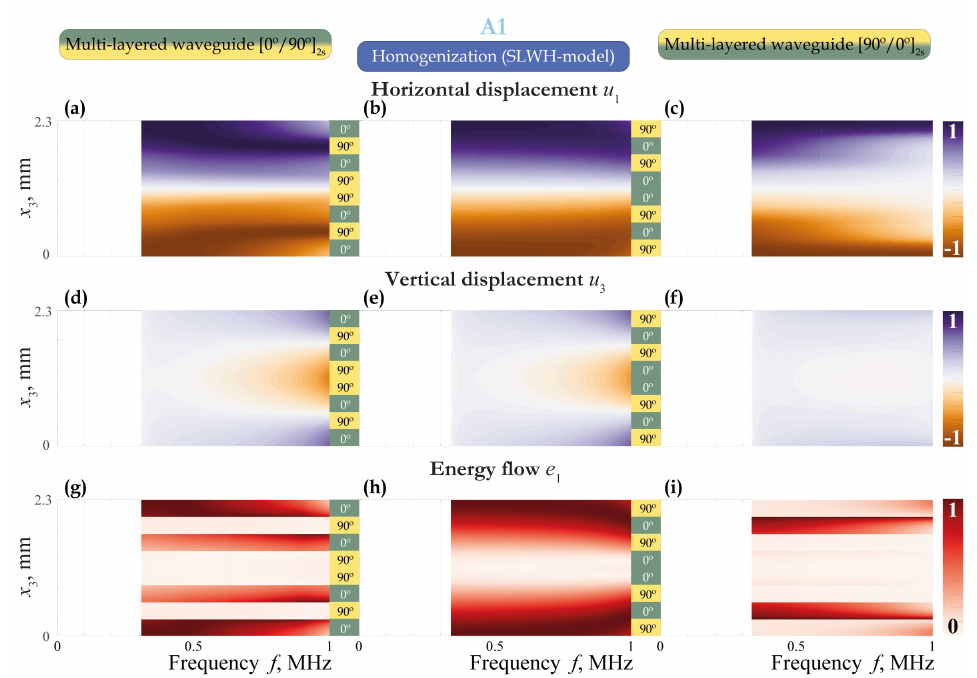
Figure 8. Eigenforms for the guided wave A1 propagating in multi-layered waveguide [ 0 ◦ ,90 ◦ ] 2s ( a , d , g ), homogeneous waveguide according to the SLWH-model ( b , e , h ), and multi-layered waveguide [ 90 ◦ ,0 ◦ ] 2s ( c , f , i ).